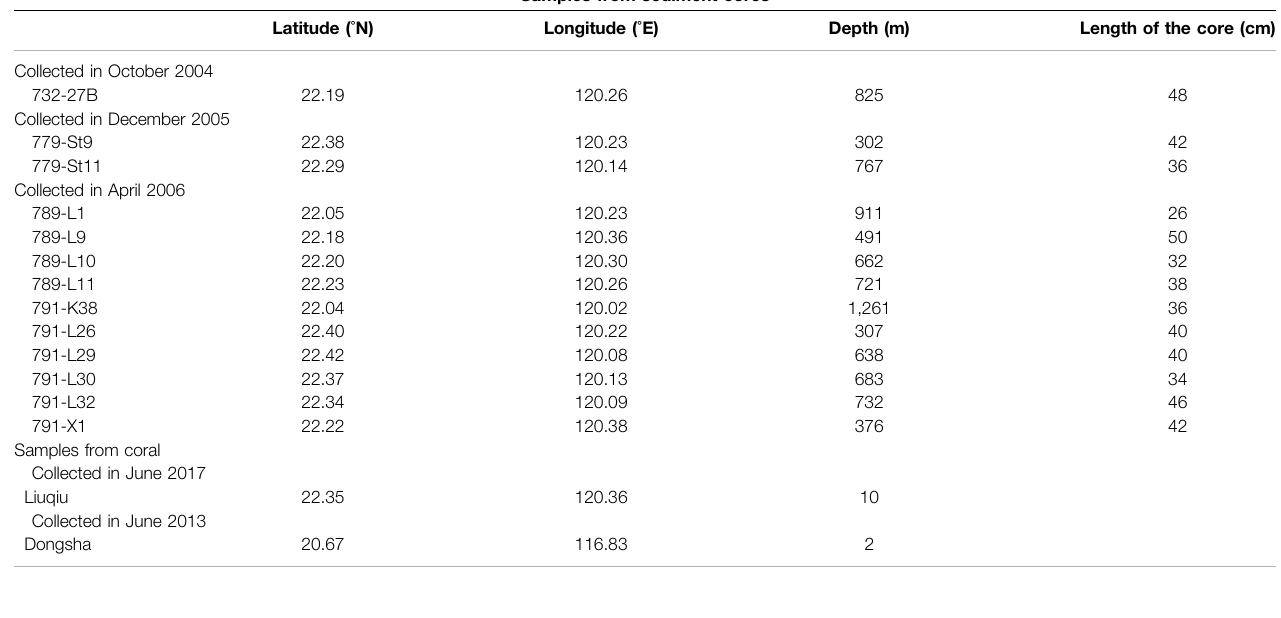
TABLE 1 | The information of coring sites.